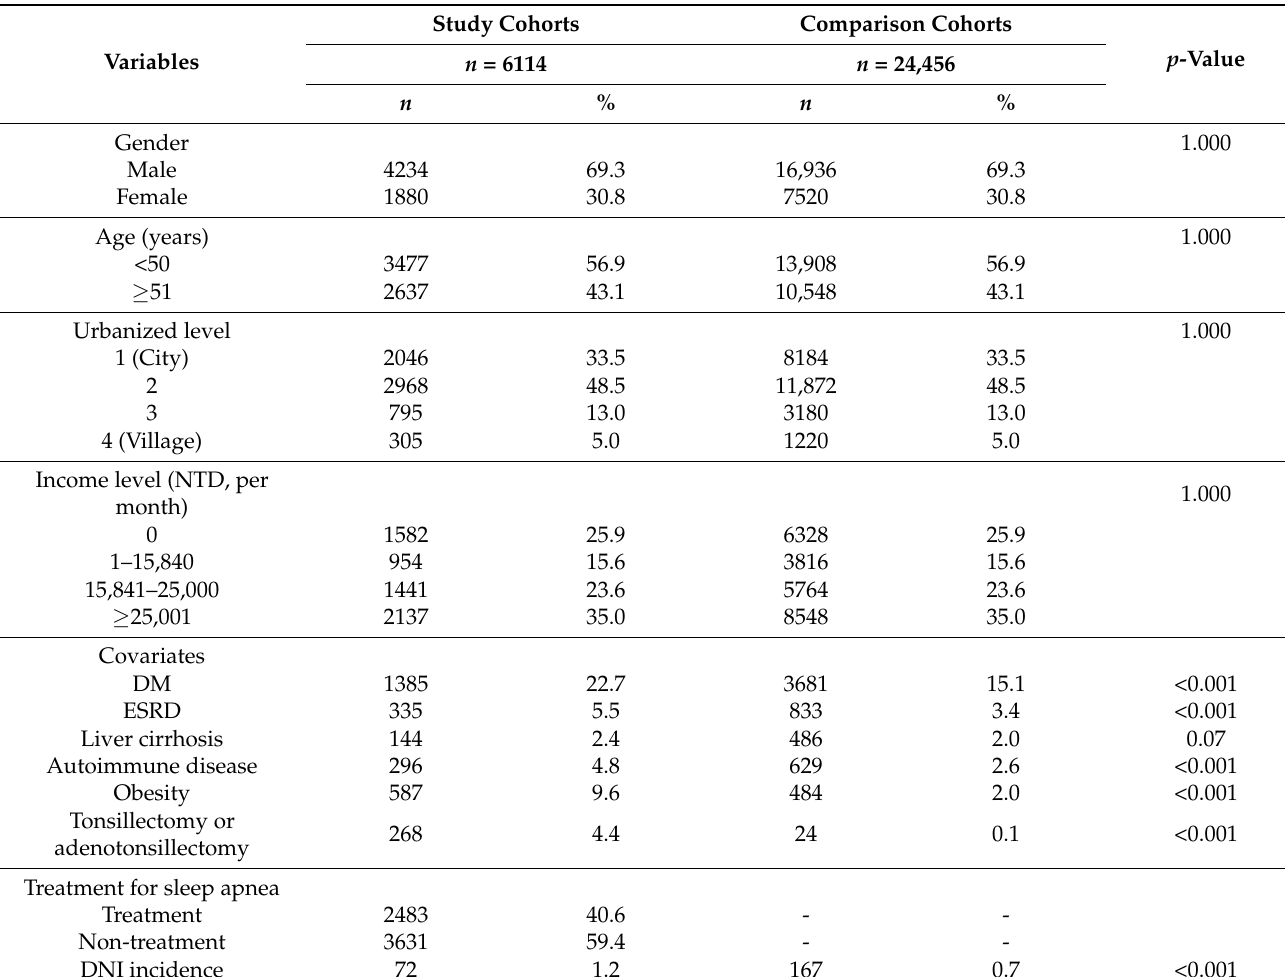
Table 1. Baseline characteristics of our cohorts.